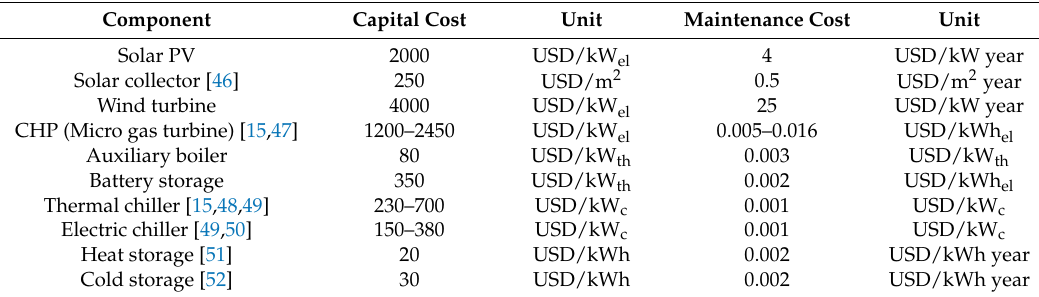
Table 4. Capital cost of each component.